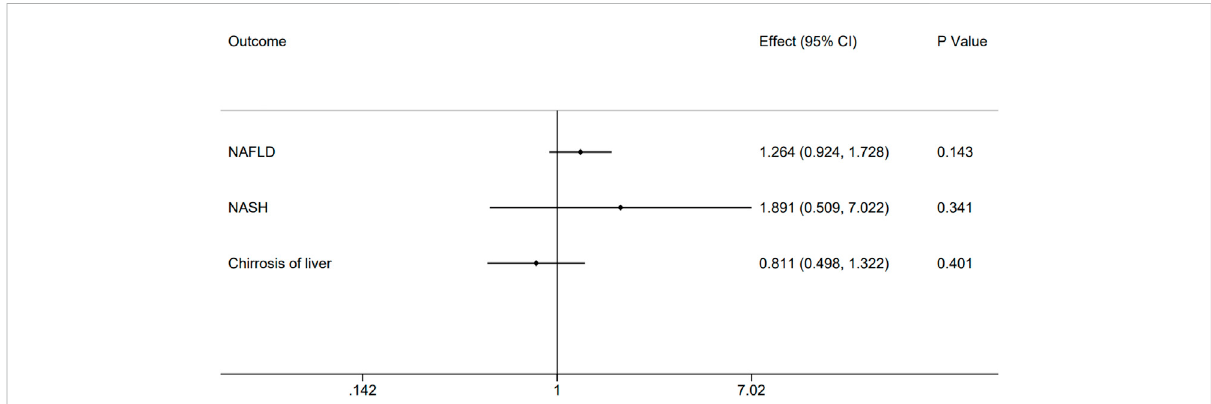
FIGURE 2 Causal impact of genetically predicted non-alcoholicfatty related liver diseases, NAFLD, NASH and Cirrhosis using 12 genome-wide signi fi cant SNPs on the plasma homocysteine. Forest plot depicting the effect of genetically predicted NAFLD, NASH and Cirrhosis on plasma homocysteine ( n = 12) using inverse-variance weighted Mendelian randomization.